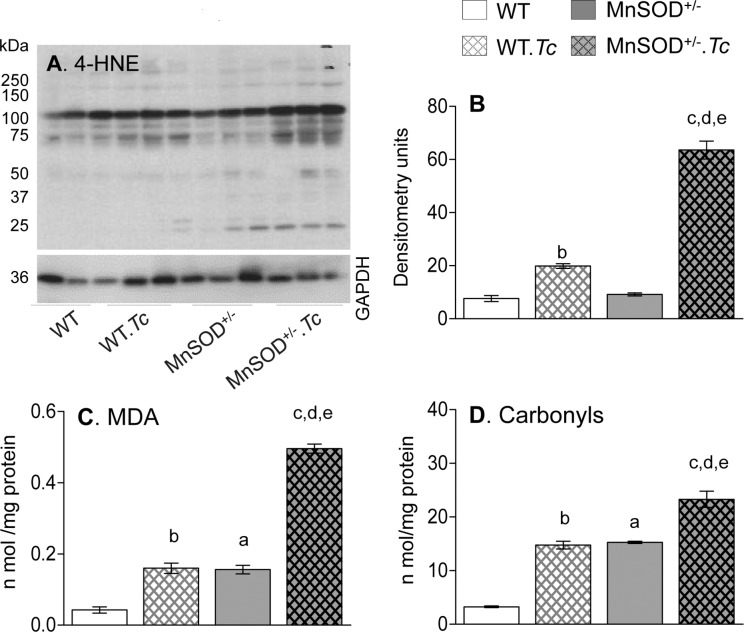
Effects of MnSOD deficiency on myocardial oxidative stress in chagasic mice.C57BL/6 (WT, MnSOD+/-) mice were sacrificed at 150 days post-infection corresponding to chronic disease phase. (A&B) Representative Western blot images for myocardial levels of 4-hydroxynonenal (4-HNE) and GAPDH (loading control) are shown (A, n = 3 mice per group). Densitometry analysis was performed for Western blot gels representing n = 6 mice per group (duplicate observations per mouse), and data were normalized to GAPDH levels (B). The myocardial levels of (C) lipid hydroperoxides / malondialdehydes (MDA) and (D) DNPH-derivatized carbonyl proteins were analyzed by an ELISA (n = 6 mice per group, triplicate observations per mouse). Data in bar graphs are plotted as mean value ± SEM. Significance is presented by a-e as described in Fig 1 (p value < 0.05).